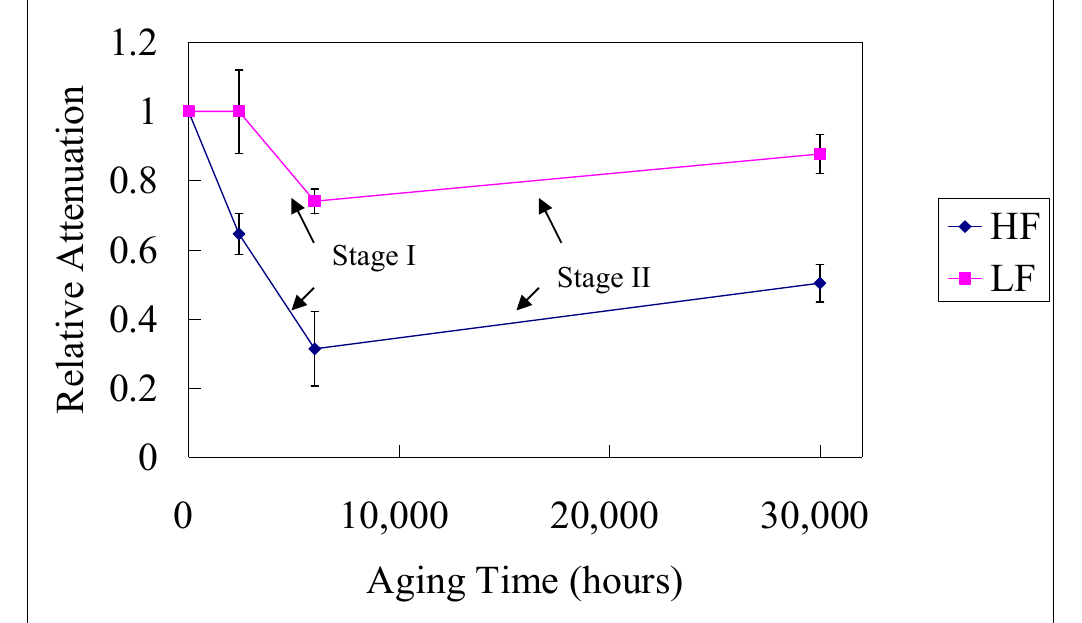
Appl. Sci. 2020 , 10 , x FOR PEER REVIEW Figure 13. Variation of relative attenuation with aging time. Figure 13. Variation of relative attenuation with aging time.